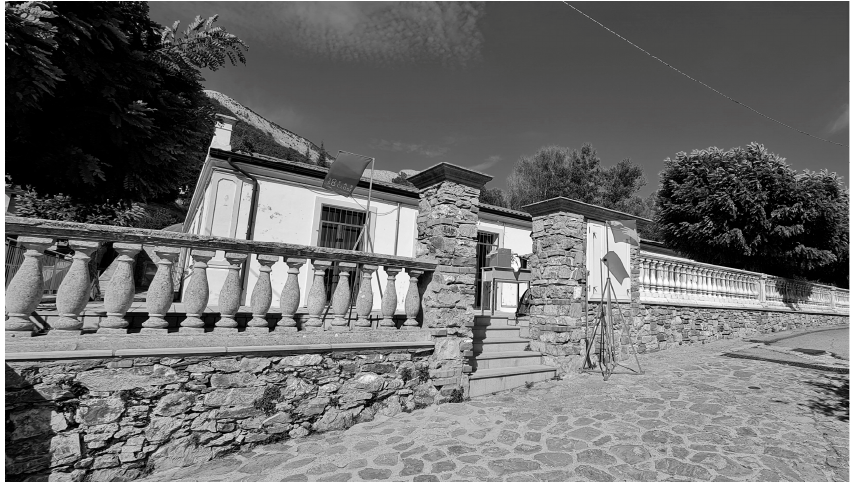
Figure 4. The building of MULA+. Source: Arte Pollino.